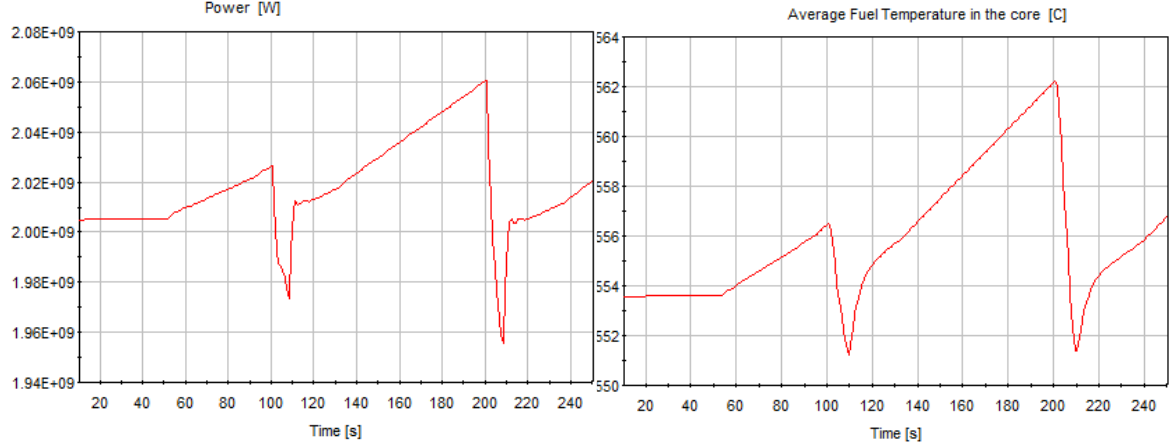
Figure 7: Time evolution of the Power (left) and of the average fuel temperature